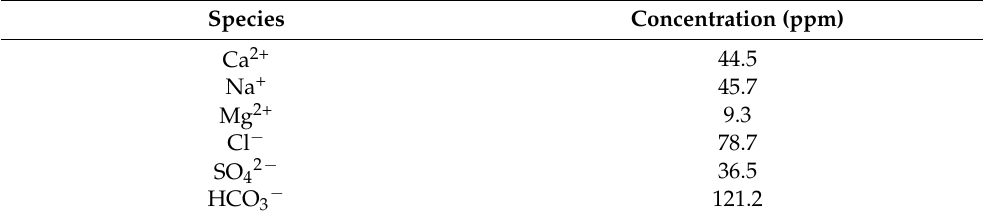
Table 1. Ionic species and relative concentration for the preparation of